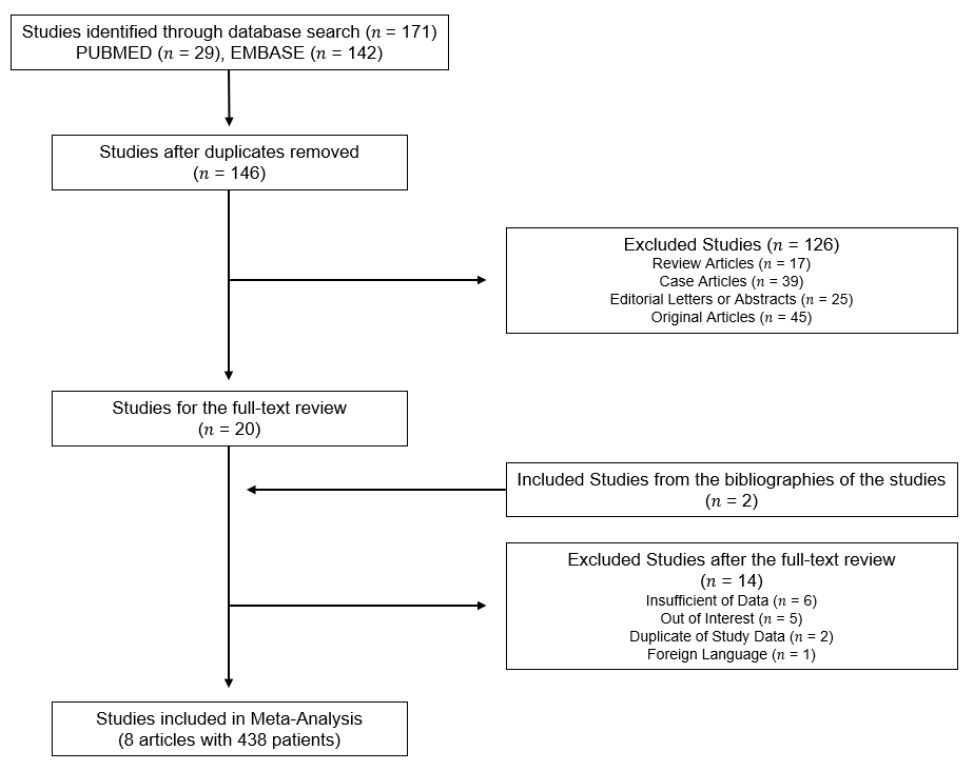
Figure 1. Flow Diagram of the Study Selection.